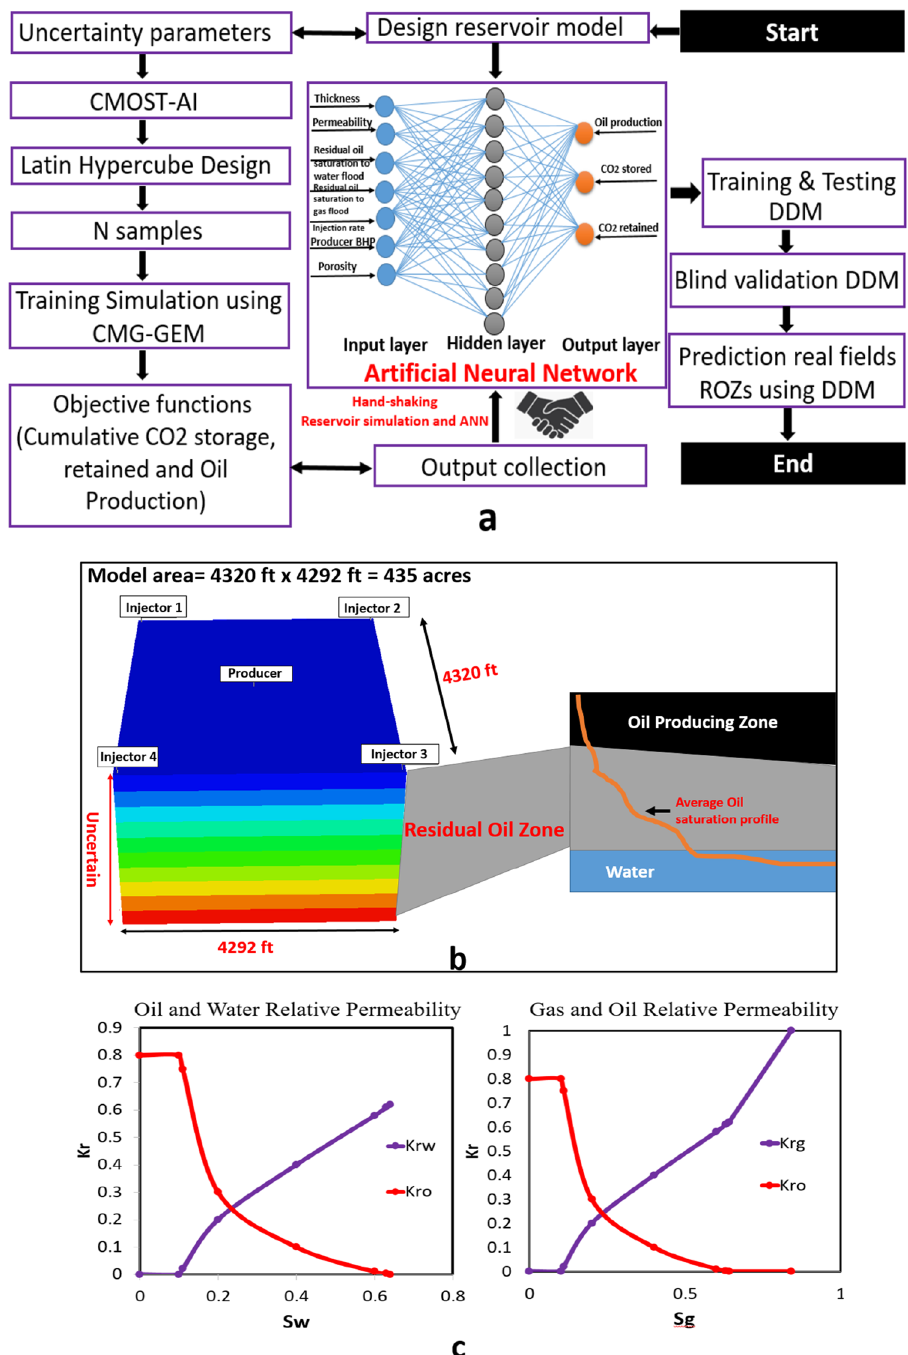
Figure 1. Data-driven modelling workflow, reservoir model, and rock-fluid properties. ( a ) The framework linked between the reservoir simulation and ANN for data-driven models. ( b ) The illustration of base case reservoir models and location of the Residual Oil Zone in the subsurface. ( c ) The behavior of relative permeability curves used for reservoir